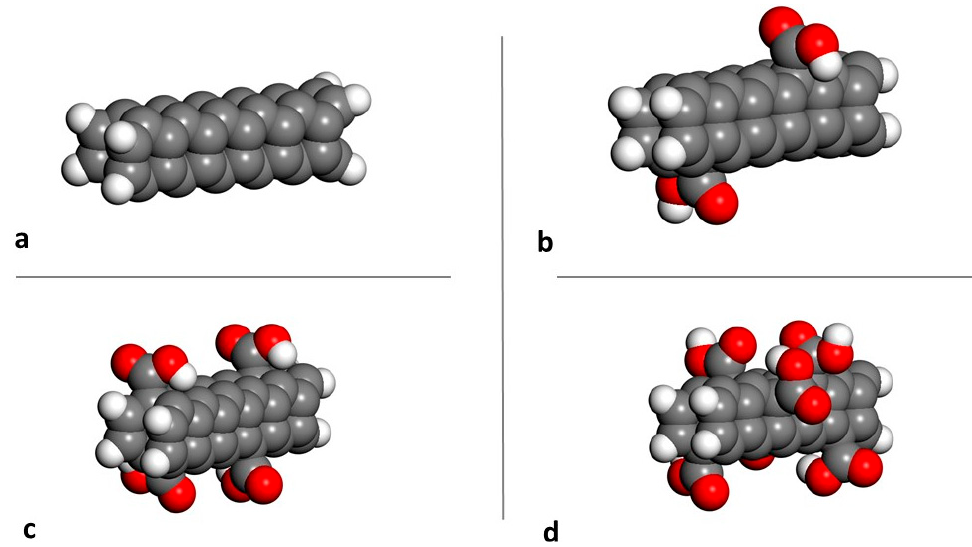
Figure 3. ( a ) pristine SWCNT (2, 2) and functionalized with ( b ) 2 COOH groups, ( c ) 4 groups and ( d ) 6 groups. Red: oxygen, White: hydrogen, Grey: carbon. Geometrical features of the models used to calculate the mechanical properties are listed in Table 1. Table 1. Models used to calculate mechanical properties.